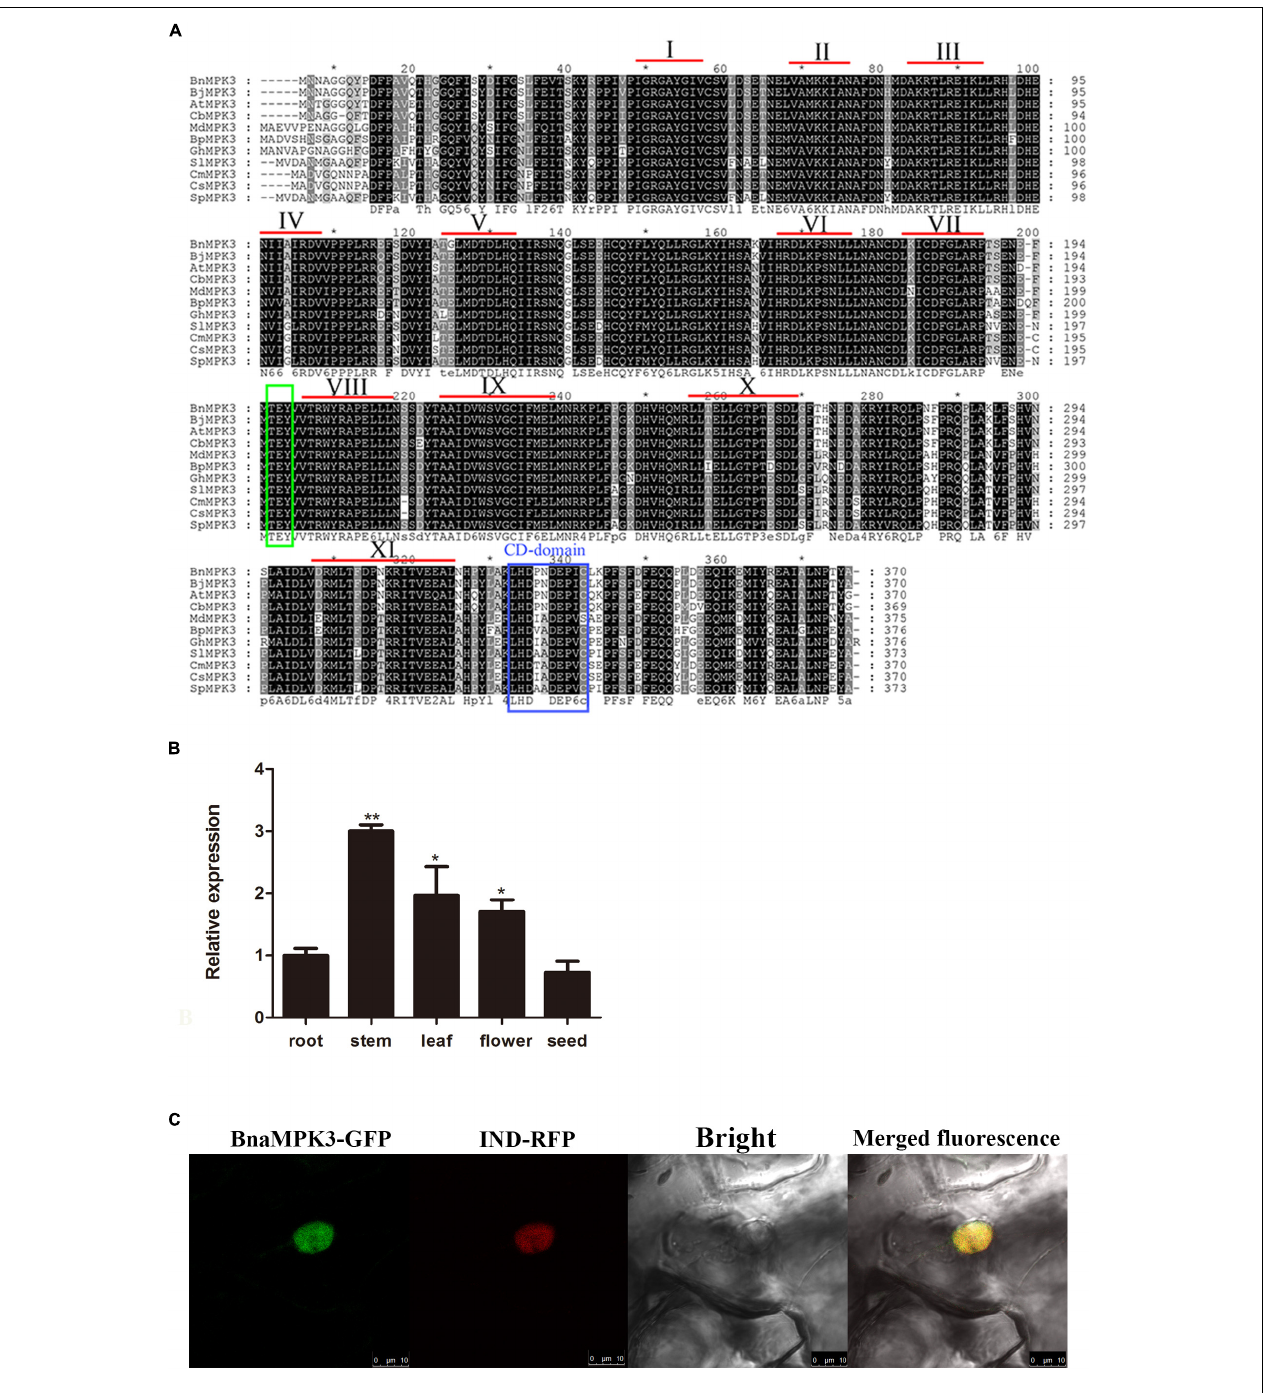
FIGURE 1 | Sequence analysis of BnaMPK3 . (A) Sequence alignment of BnaMPK3 and its homologs. The amino acid sequence of BnaMPK3 was aligned with those of the 10 closest matching proteins from a BLAST search. Identical amino acids are shown in black boxes, and similar amino acids are shown in gray boxes. The highly conserved domain TEY is shown in green box. The CD-domain is shown in blue box. According to Hanks and Hunter (1995), 11 subdomains (I–XI) are indicated by Roman numerals. Species abbreviations are as follows: Bn: Brassica napus ; Bj: Brassica juncea ; At: Arabidopsis thaliana ; Cb: Chorispora bungeana ; Md: Malus domestica ; Bp: Betula platyphylla ; Gh: Gossypium hirsutum ; Sl: Solanum lycopersicum ; Cm: Cucumis melo ; Cs: Cucumis sativus , Sp: Solanum peruvianum . (B) Expression profiles of BnaMPK3 . Relative expression levels of BnaMPK3 in different tissues were determined by real-time quantitative PCR. Values are means of three replicates. The error bars show the standard deviation. The significances of between each tissue and root are indicated (Student’s t -test, ∗∗∗ P < 0.001, ∗∗ 0.001 < P < 0.01 or ∗ 0.01 < P < 0.05). (C) Subcellular localization of BnaMPK3. In planta localization in Nicotiana benthamiana leaves of BnaMPK3-green fluorescent protein (GFP), IND (nuclear marker protein)-red fluorescent protein (RFP) and merged fluorescence from RFP and GFP.